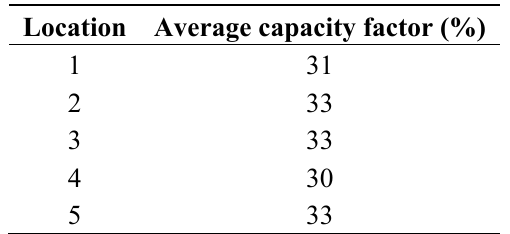
Table 2. Variables definition.